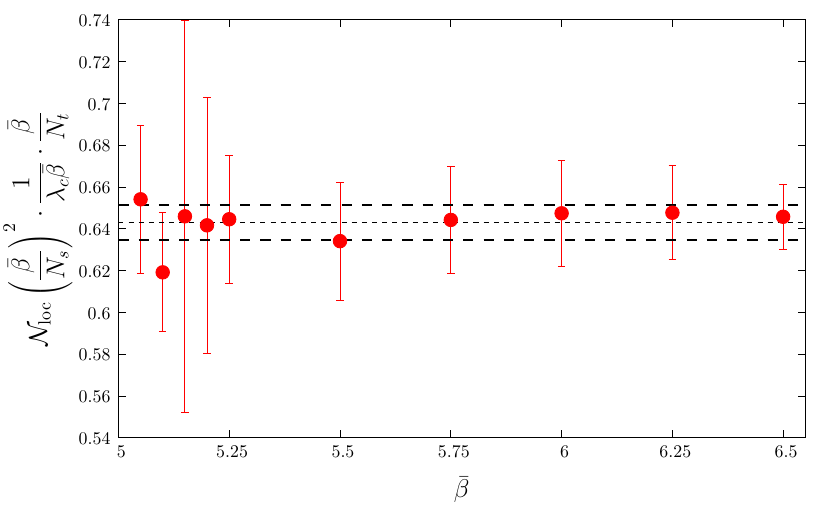
Figure 13 . Density of localised modes times T/λ c phys in physical units. A constant fit and the corresponding error band (dashed lines) are also